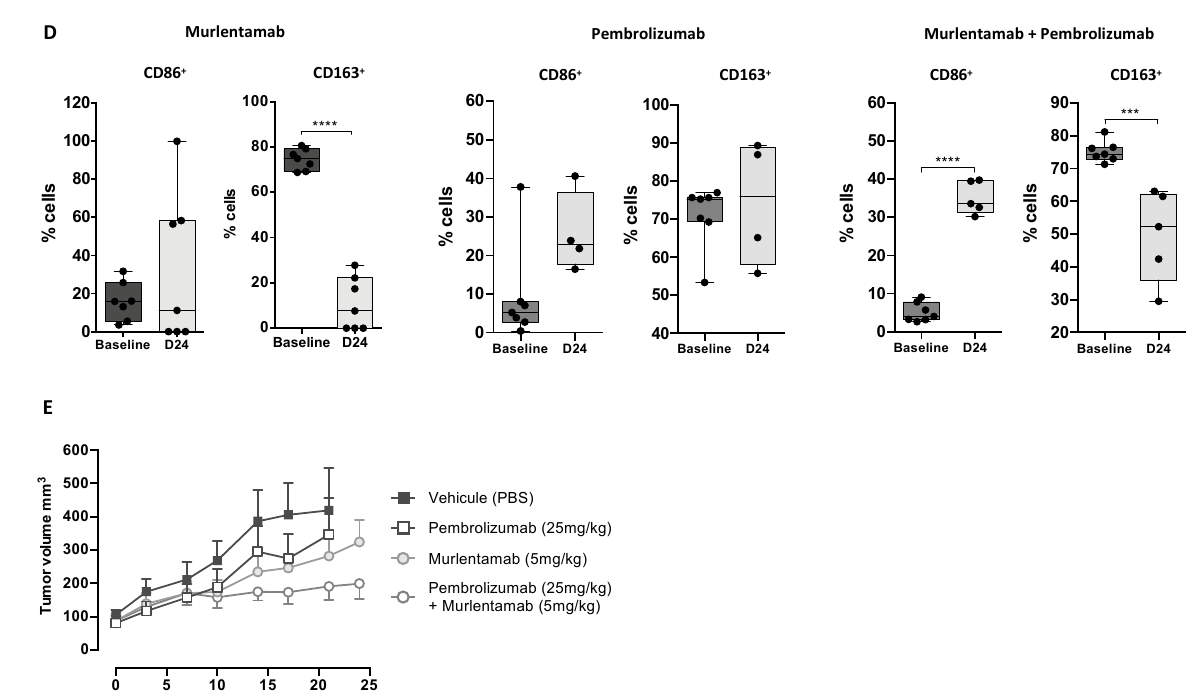
Figure 5. Murlentamab/pembrolizumab combination accentuates the anti-tumoral effect of murlentamab monotherapy